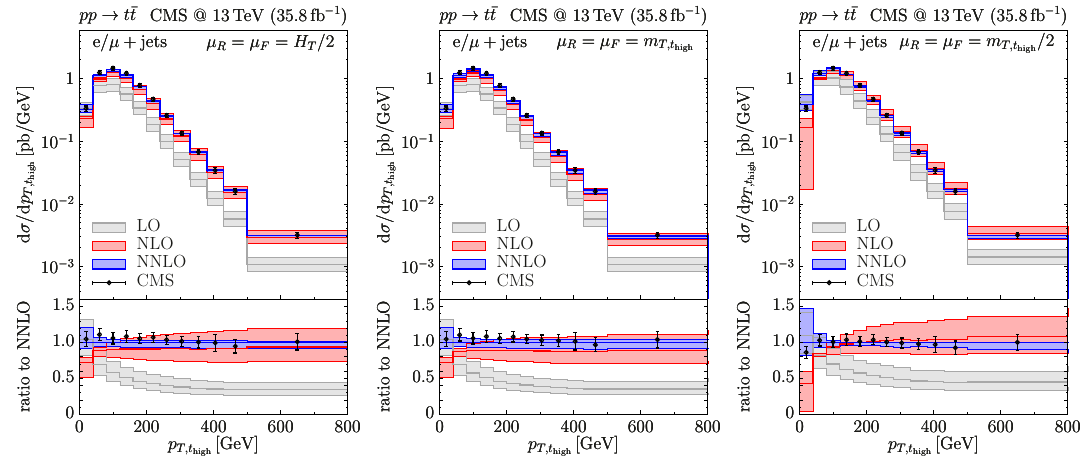
Figure 1 . Single-di(cid:11)erential cross sections as a function of p T;t and NNLO results for central scales equal to H T = 2 (left), m T;t